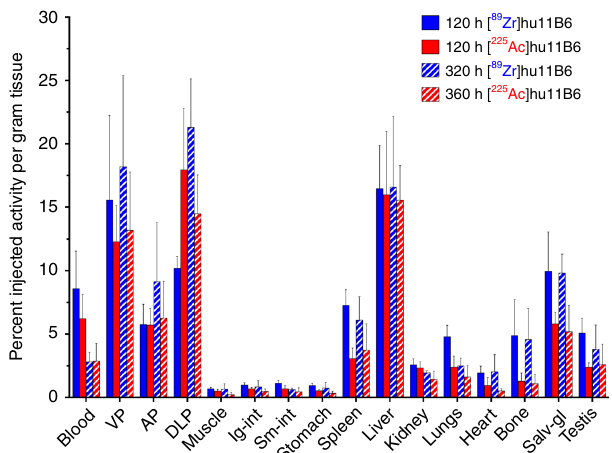
Fig. 5 [ 89 Zr]hu11B6 is a surrogate PET reporter for [ 225 Ac]hu11B6 distribution in vivo. A pharmacokinetic comparison of [ 89 Zr]hu11B6 and [ 225 Ac]hu11B6 distribution in Hi- Myc x pb_ KLK2 mice shows that tissue uptake and blood clearance of the 89 Zr-labeled diagnostic PET hu11B6 agent is comparable to the alpha emitting 225 Ac-labeled therapeutic analog at both time points investigated. This analogous pharmacokinetic pro fi le suggests that [ 89 Zr]hu11B6-PET can be utilized as a reporter for [ 225 Ac] hu11B6 therapy in vivo. The tumor accumulation of both agents in all three prostate lobes is